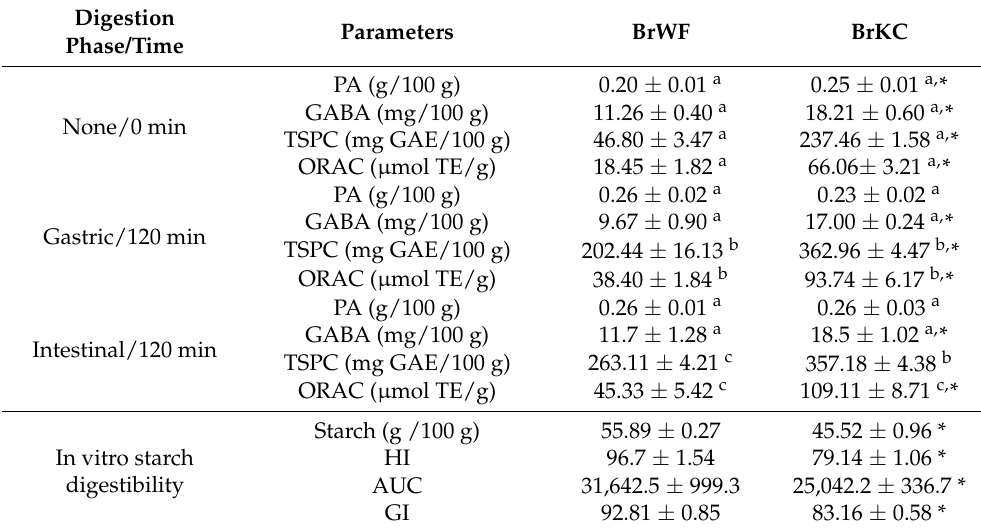
Table 4. In vitro starch digestibility and changes in PA, GABA, TSPC and AA at different phases of digestion for BrWF (100% WF) and BrKC with optimal formulation (5% SKF, 23.1% SCF, and 71.9%